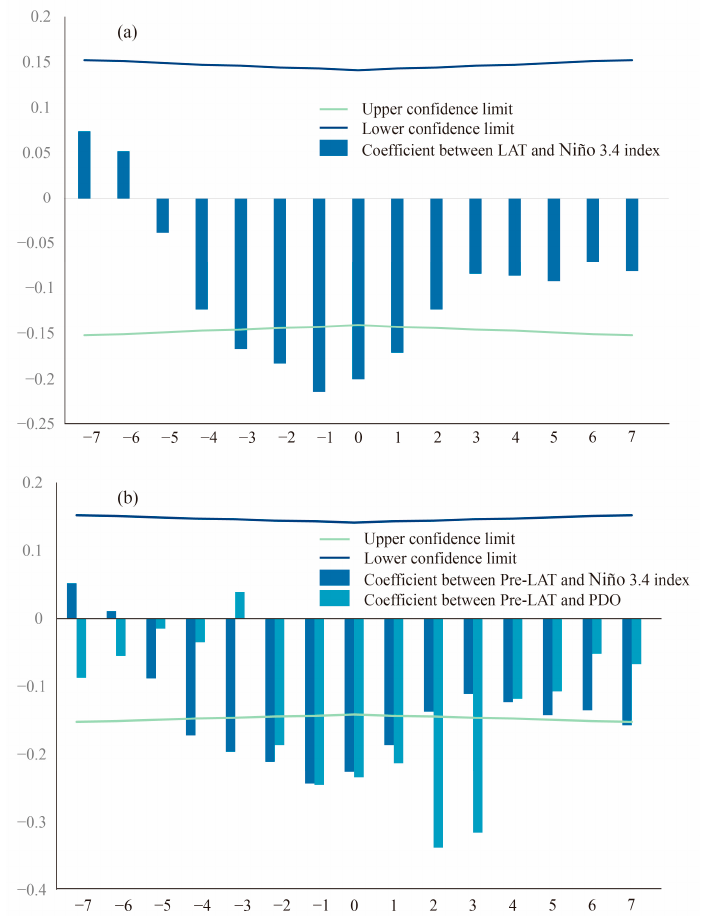
Figure 6. ( a ) Cross-correlation coefficients between the center of gravity latitude of AI-Effort and the Niño 3.4 index. ( b ) Cross-correlation coefficients between the predicted center of gravity latitude and the Niño 3.4 index and the PDO.